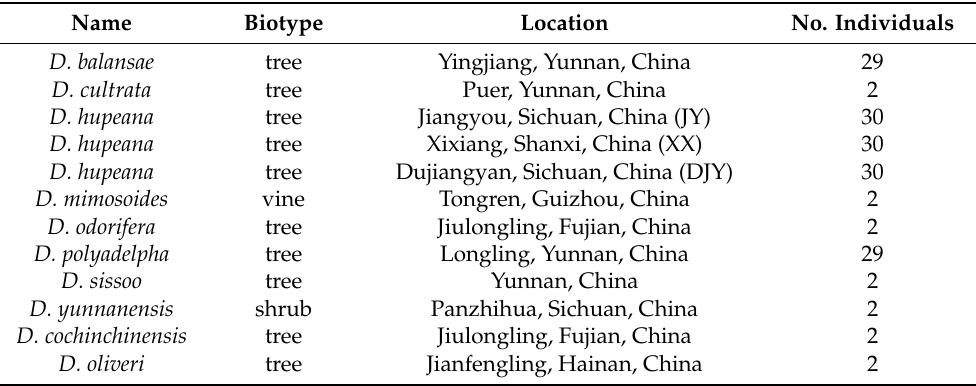
Table 1. Information of plant materials of the Dalbergia genus collected in this